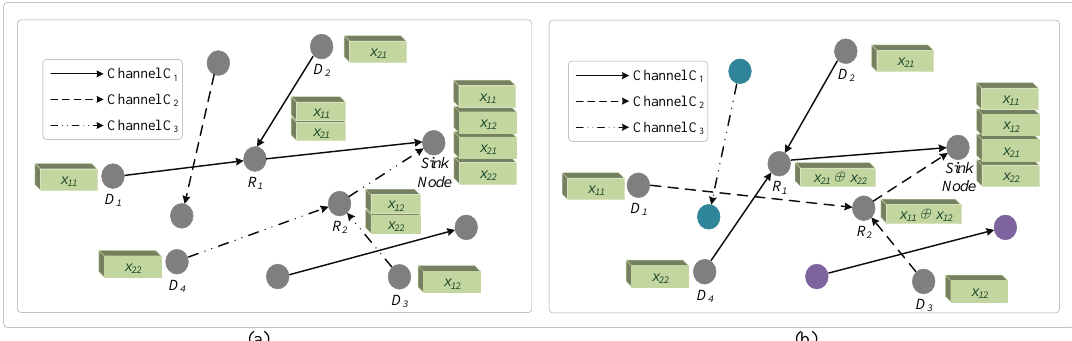
Figure 1. Different methods to transmit data with millimeter-wave technology. ( a ) Traditional transmission method with random channel assignment; ( b ) the transmission using the content-based multi-channel network coding (CMNC)